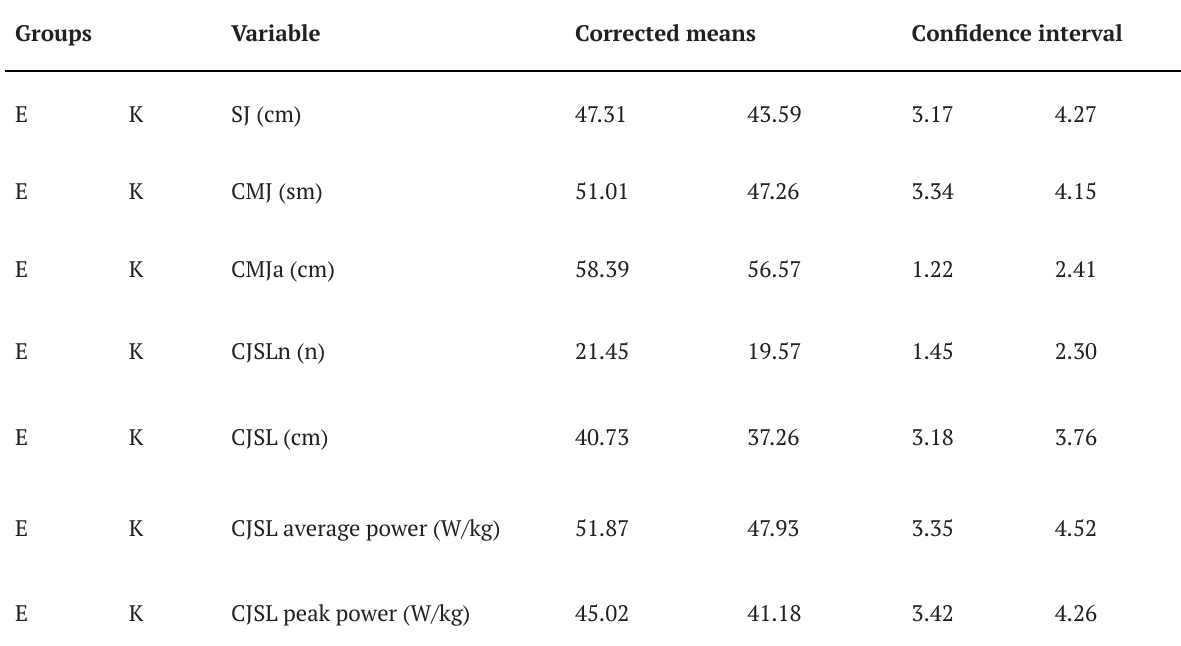
Table 3. Corrected means and confidence intervals of the E and K groups in the variables of lower limb explosive strength after the treatments applied Groups Variable Corrected means Confidence